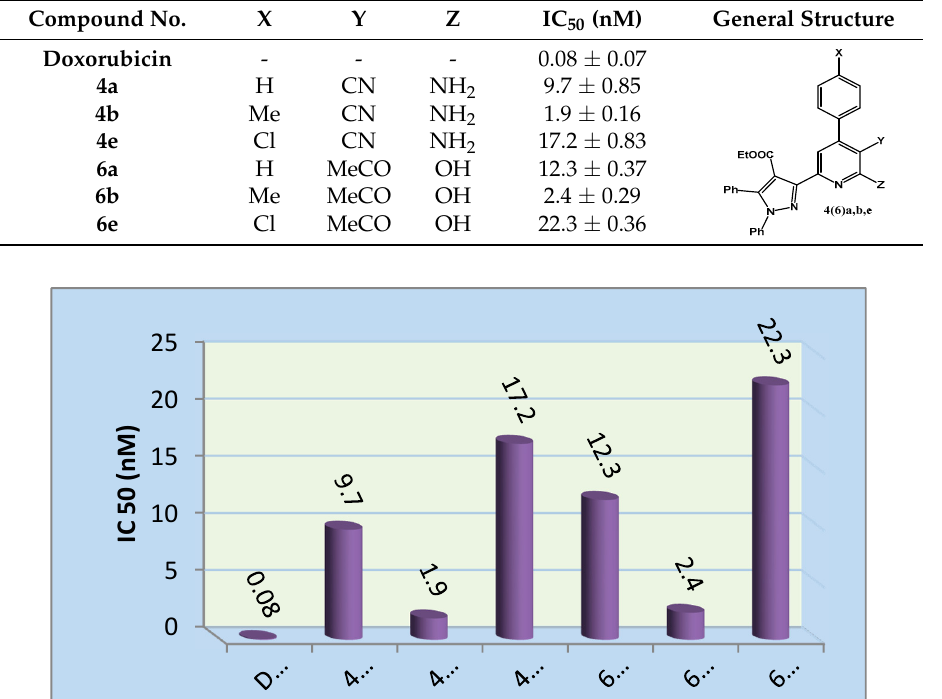
Figure 1. Cytotoxic activities of tested compounds against HEPG2-1.